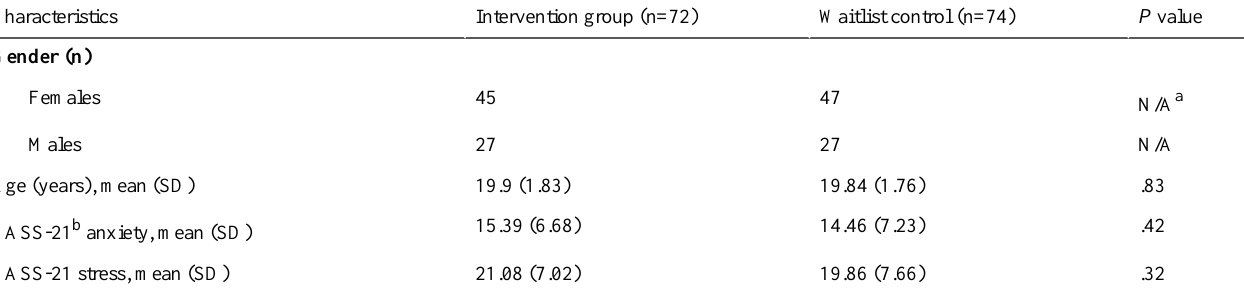
Table 1. Summary of participant characteristics at baseline